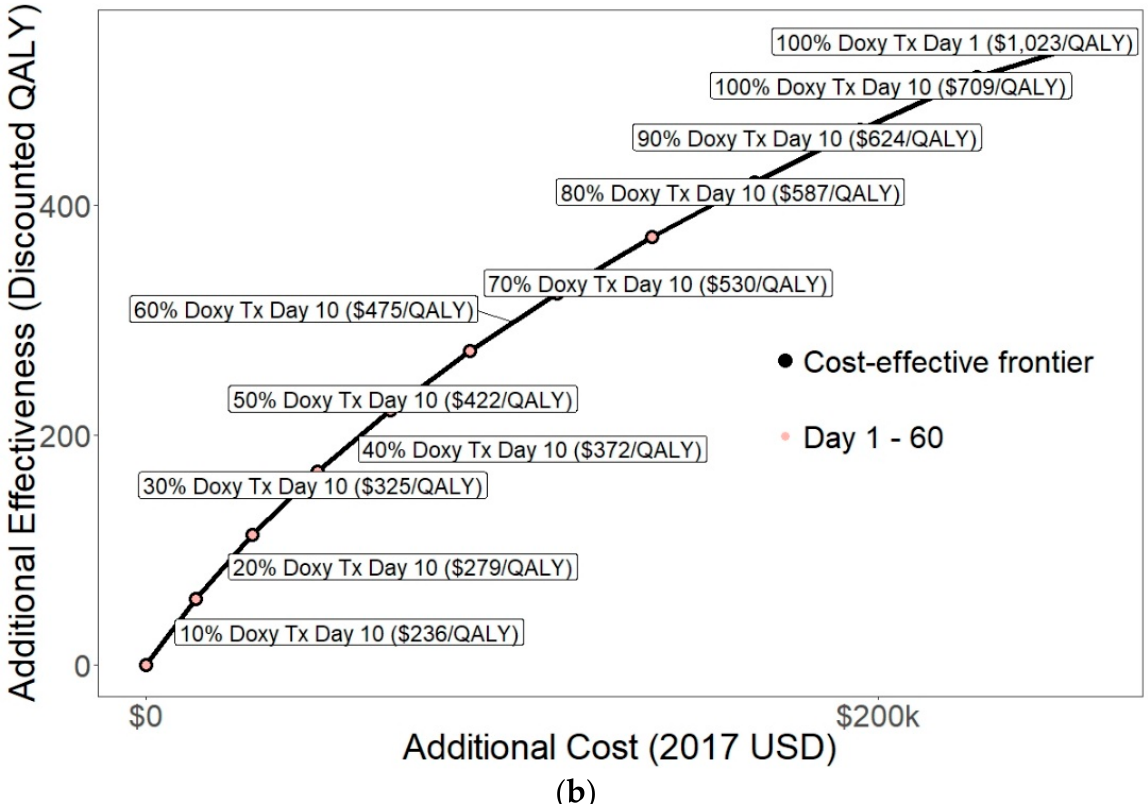
Figure 3. Cost-effectiveness frontier: ( a ). Full cost-effectiveness frontier; ( b ). Detailed view of cost-effectiveness frontier near the preferred decision.